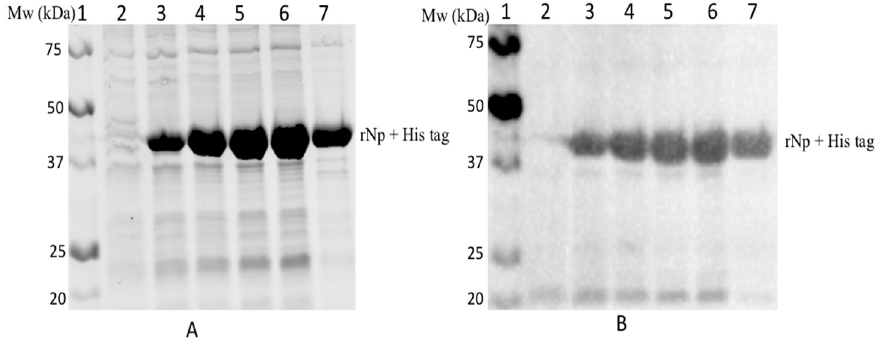
Figure 3. SDS-PAGE ( A ) and western blot ( B ) of the bacterially expressed RVFV rNp. SDS-PAGE ( A ) and western blot ( B ) of the bacterially expressed RVFV rNp. Lane 1: Precision Plus Protein Unstained Standard marker, lane 2: uninduced lysate and lane 3 to lane 7: IPTG induced lysate collected hourly from 1 to 5 h.